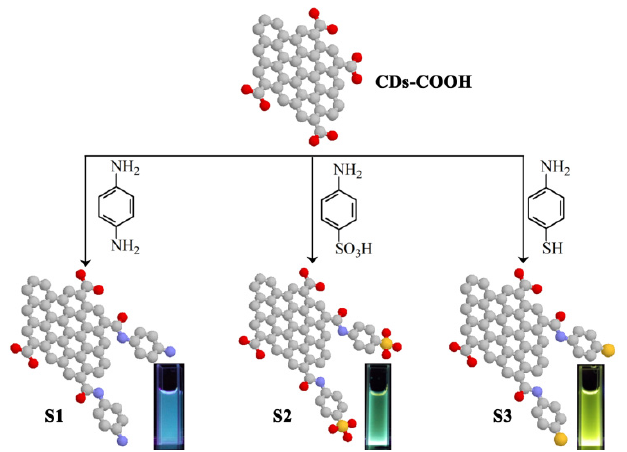
Figure 1. Schematic of modifying CDs with p-phenylenediamine (S1), sulfanilic acid (S2), and 4-aminothiophenol (S3), respectively, and their corresponding emission photos under UV excitation of 356 nm.